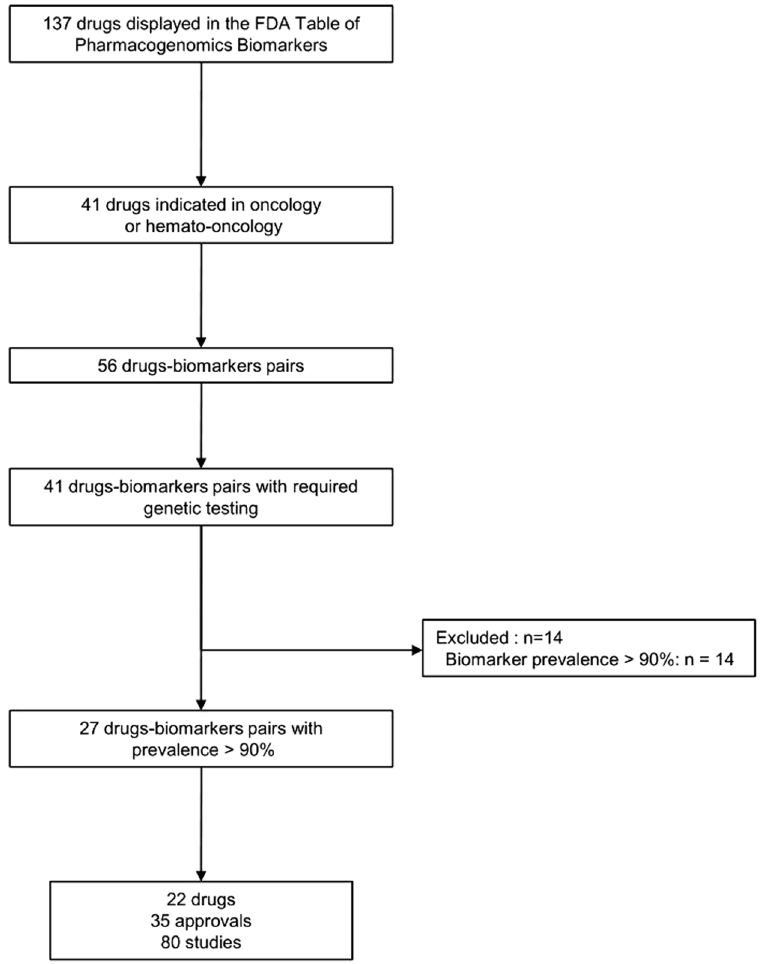
Figure 1. Flow of drugs, approvals and clinical trials included in the current